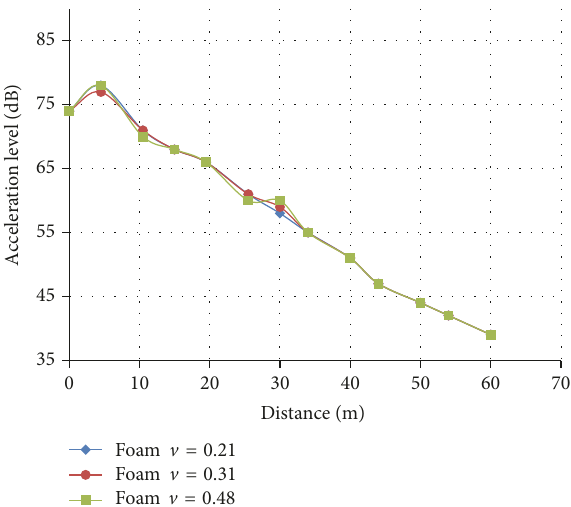
Figure 17: The comparison of acceleration level among cases 1 , 4 , and 5 in Scheme 4 .